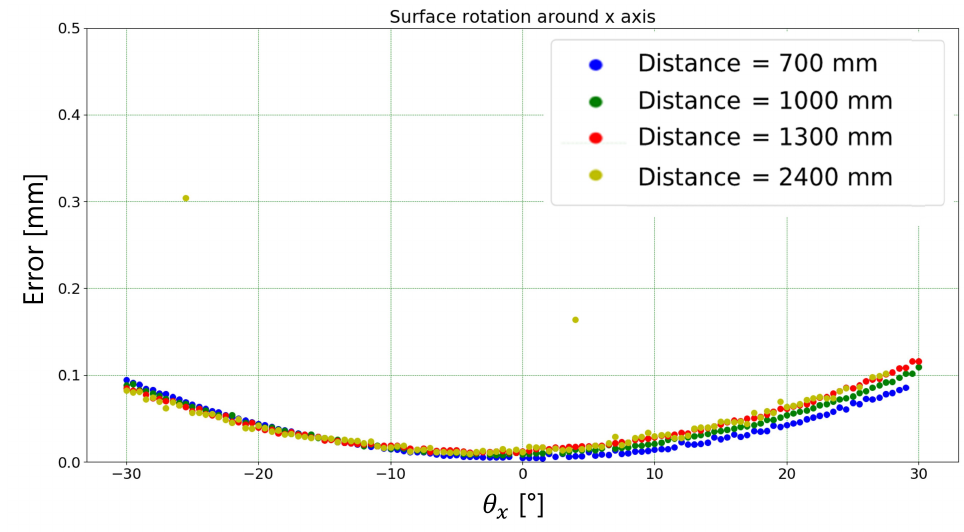
Figure 17. Absolute error (i.e., difference between mean width measured by the proposed algorithm and the target width) in millimeters for each rotation angle (around x axis) and each working distance tested.